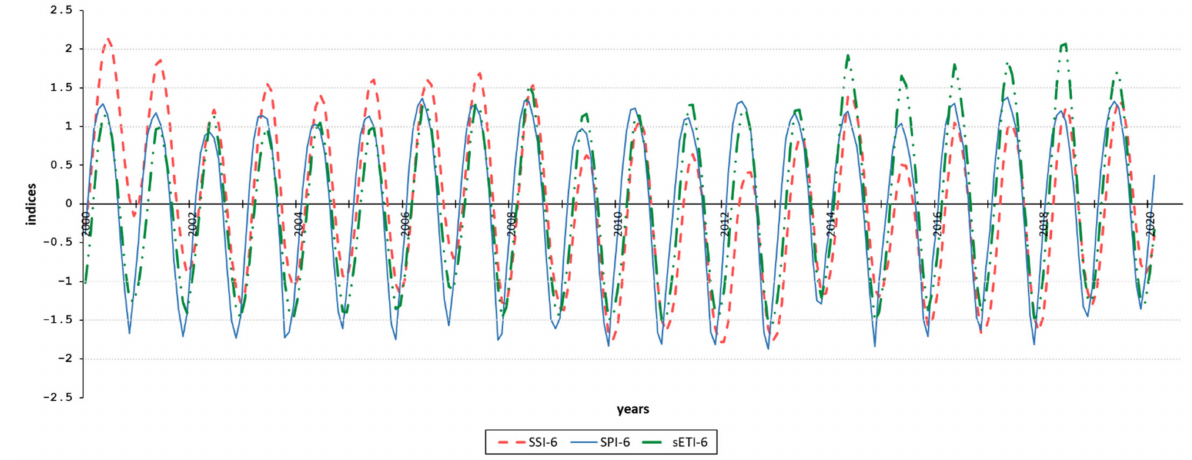
Figure 10. Six-month time steps SPI-6, SSI-6, and sETI-6.